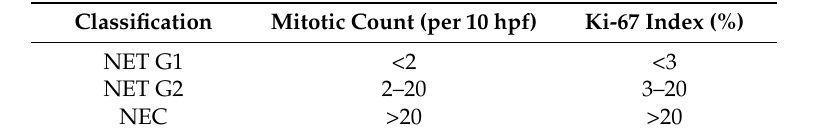
Table 1. WHO 2010 classification of